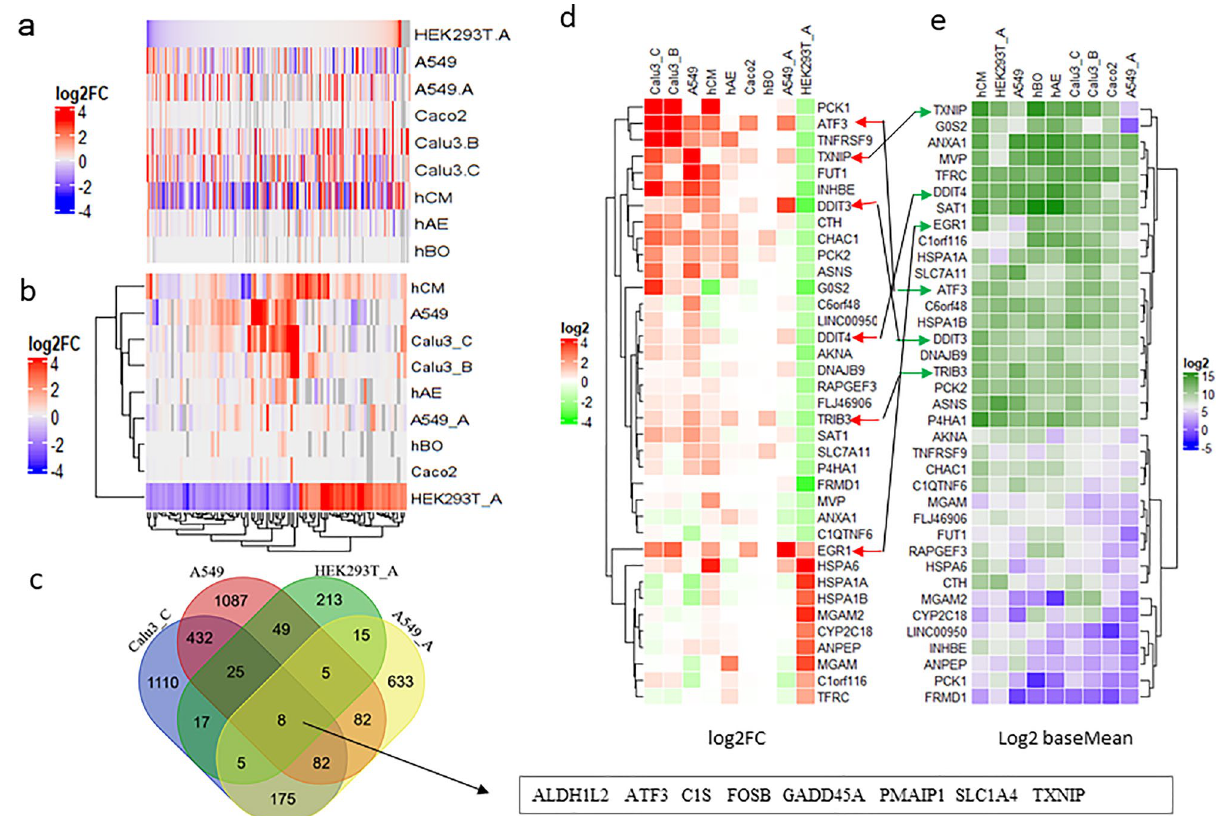
Figure 4. Common DEGs and genes of interest. ( a ) Heatmap view of the log2FC value of all genes in SARS- CoV-2 infected HEK293T-hACE2 cells versus those in other infected cell lines. Grey color indicates that the log2FC value are not available in the cell lines. ( b ) Heatmap view of genes with the log2FC value ≥ 2 or log2FC ≤ -1.5 in SARS-CoV-2 infected HEK293T-hACE2 cells versus those in other infected cell lines. Grey color indicates the log2FC value is not available in the cell lines. ( c ) Venn Diagram showing 8 common DEGs of infection in HEK293T-hACE2, A549, A549-hACE2, and Calu3_C cells. ( d ) Heatmap view of log2FC value of genes of interest. ( e ) Heatmap view of baseMean value (mean gene expression level calculated by DEseq2) of genes of interest. HEK293T_A/HEK293T.A and A549_A/A549.A represent HEK293T or A549 with hACE2 overexpression, respectively. Calu3_B/Calu3.B and Calu3_C/Calu3.C represent data by Wyler E. (bioRxiv) and Blanco-Melo D. (Cell),